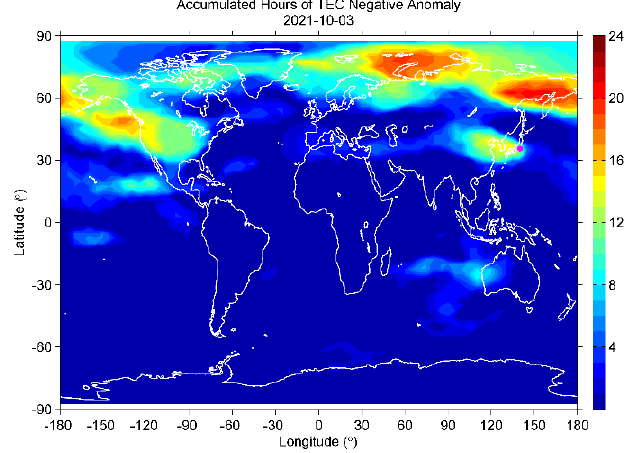
Figure 21. Same as in Figure 19, but for negative anomaly on 3 October.